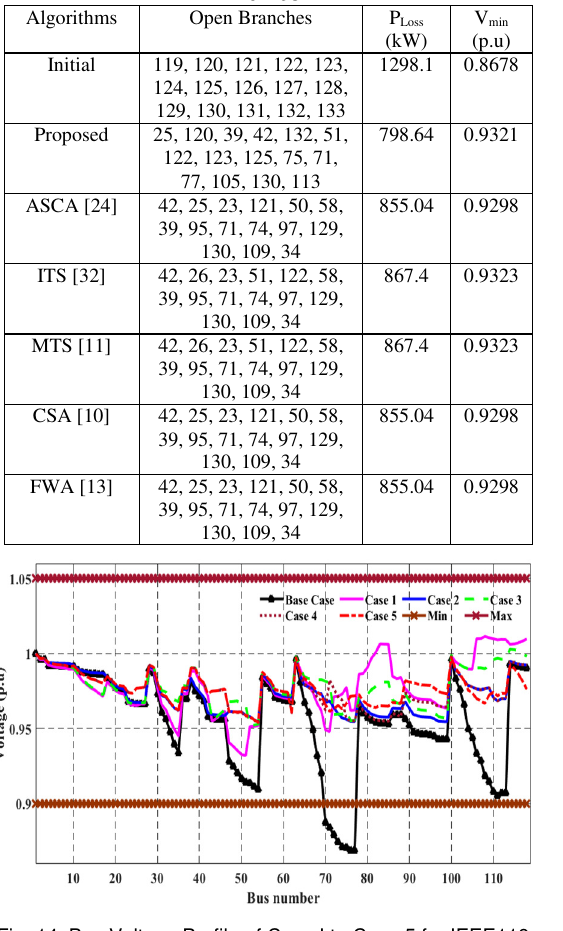
Fig. 14: Bus Voltage Profile of Case I to Case 5 for IEEE119 Bus System